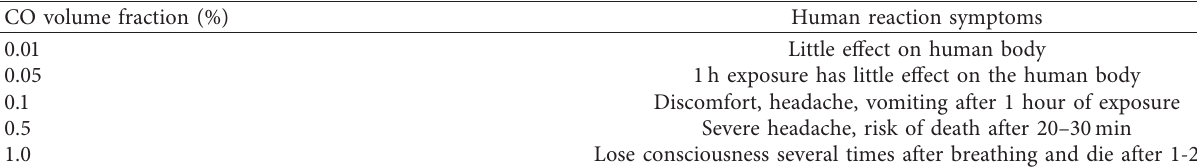
Figure 2: The proposed method in this paper. Table 1: Effects of CO on the human body.